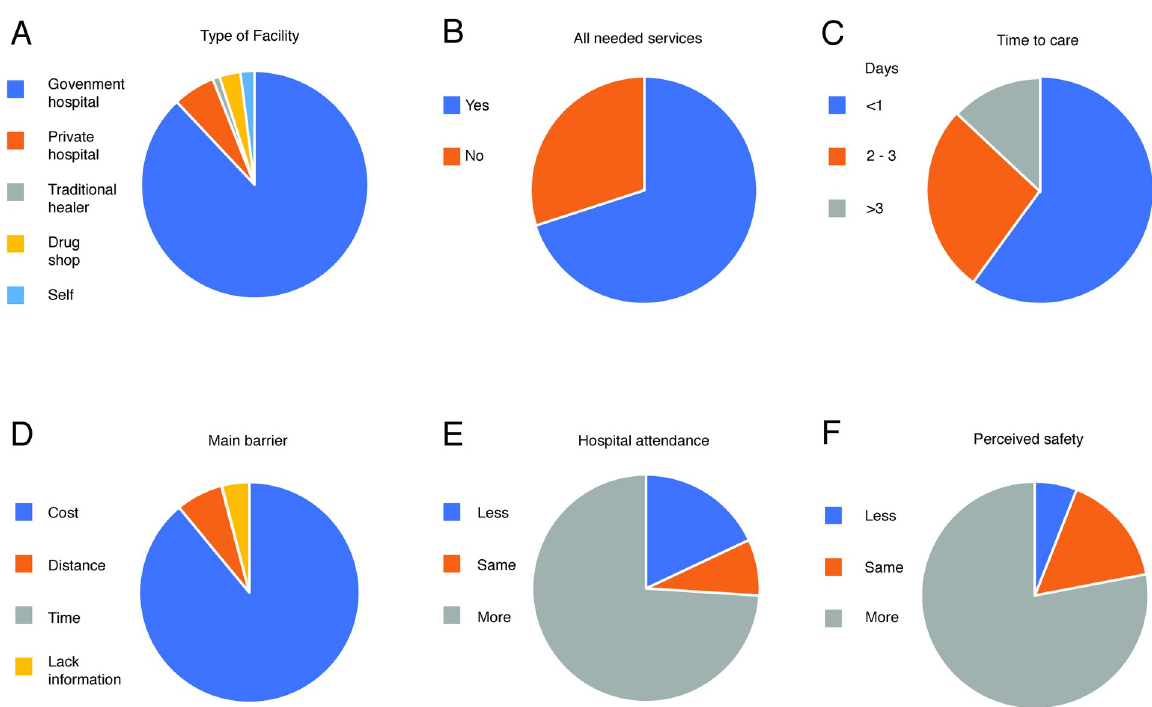
Fig 4. Features of health seeking behavior by respondents living in Kenema District, Sierra Leone. Panel A: Type of health facility utilized. Panel B: Did health facility provided all needed services. Panel C: Time lapse until care is sought. Panel D: Main barrier seeking health care. Panel E: Frequency of attendance at a hospital. Panel F: Perceived safety of health facility.